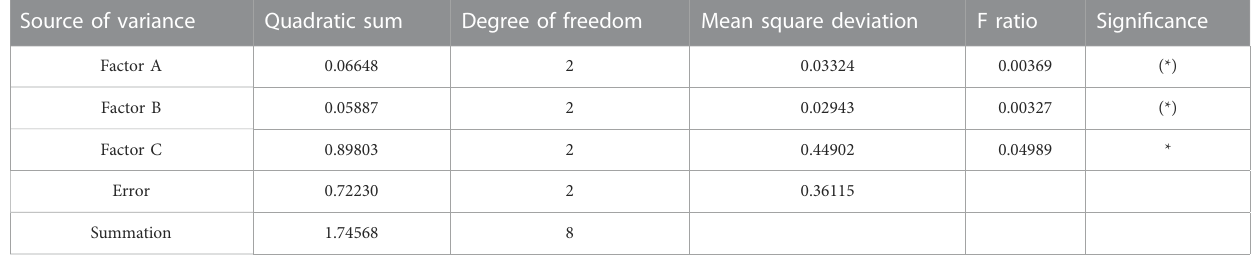
TABLE 9 Analysis of variance table. Source of